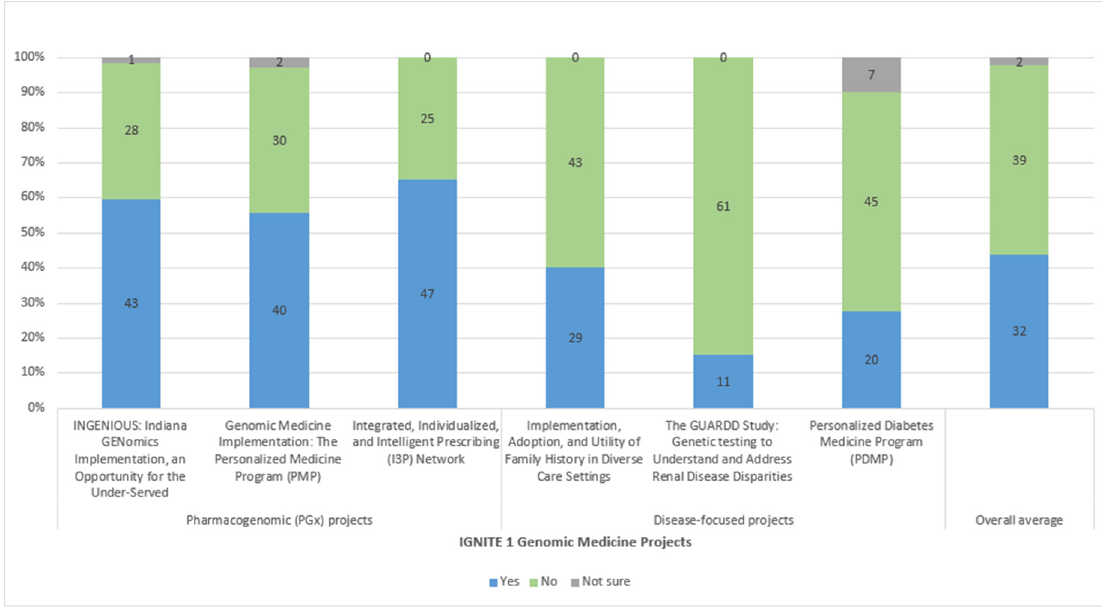
Figure 1. Number of ERIC implementation strategies used by IGNITE implementation project.